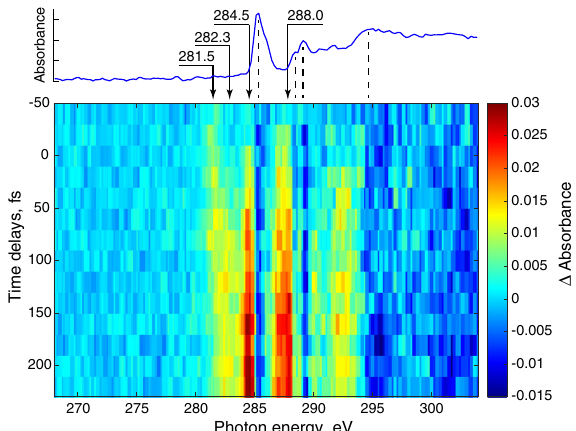
Fig. 3 Time-dependent differential absorbance. A two-dimensional map represents the differential absorbance with dependence on X-ray photon energy and the time delay between 267 nm pump and probe pulses. The top blue curve is the X-ray absorption spectrum of the ground-state pyrazine (the same plot as in Fig. 2) and vertical dashed lines project the ground-state absorption bands onto the negative (bleach) signals of the 2D map. Arrows point to absorbance energies speci fi c to different excited states. A similar map at long time delays is given in Supplementary Fig.